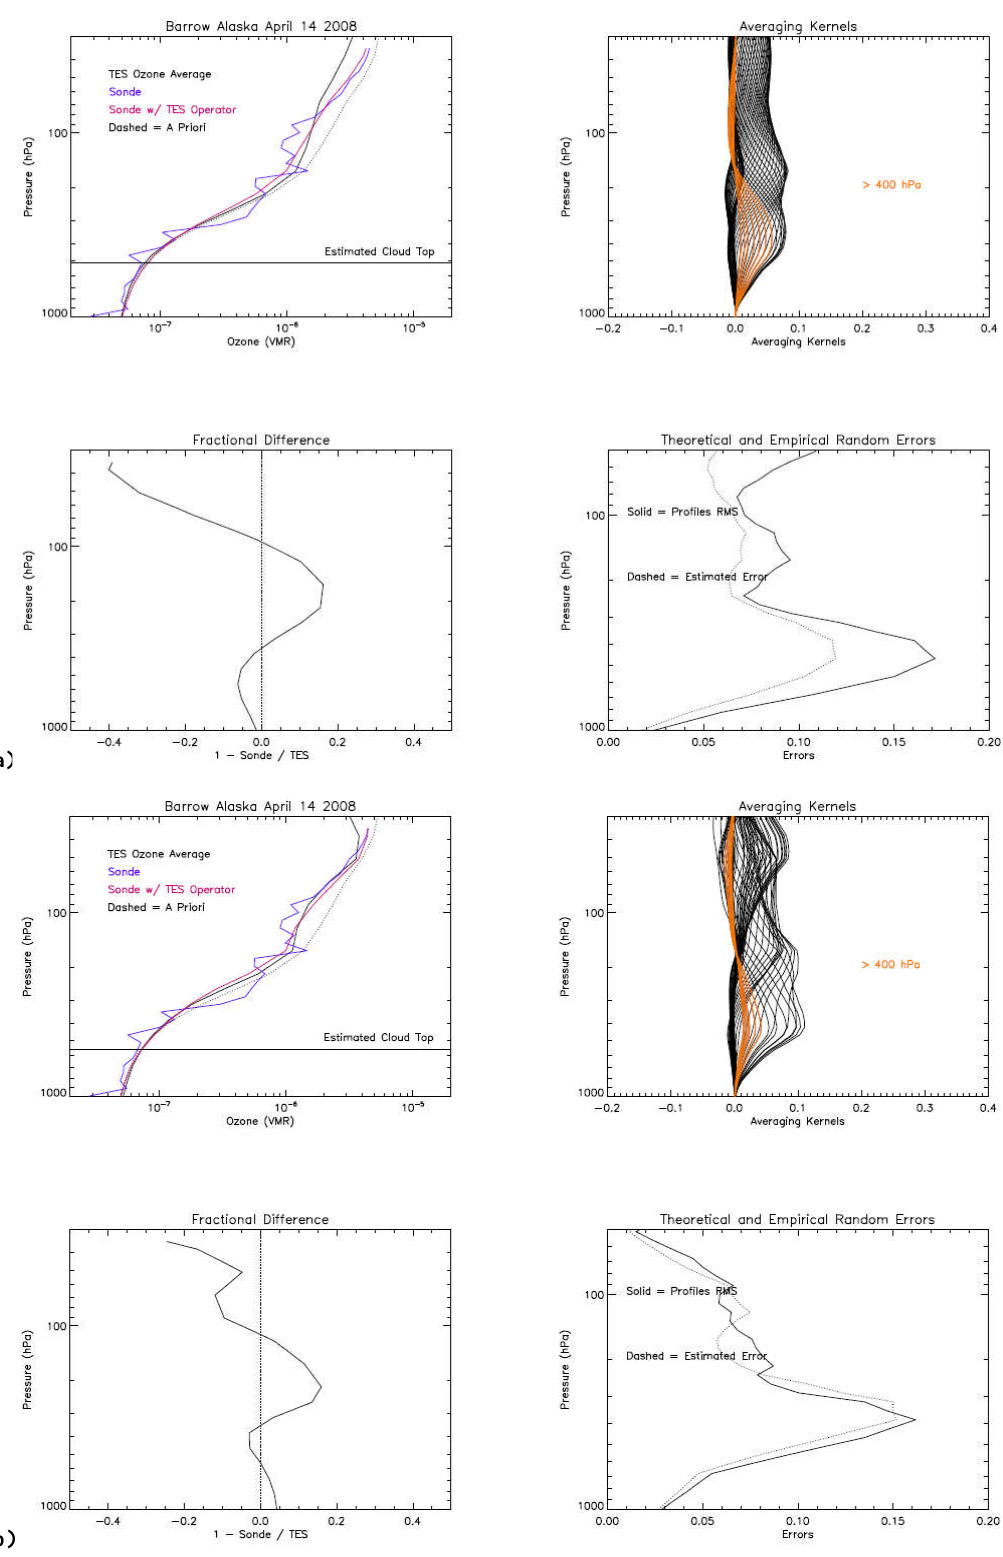
Fig. 2. The TES-stare sequence on 14 April 2008 over Barrow started at 21:45 (UTC), and the ozonesonde on that day at Barrow was launched at 22:13 (UTC), using V003 (a) and V004 (b) TES